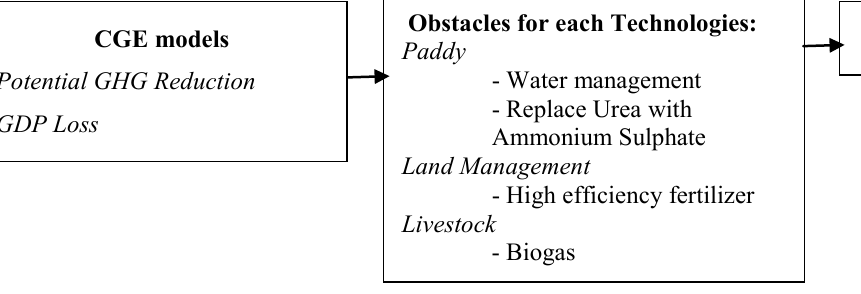
Figure 2. Methodology of the